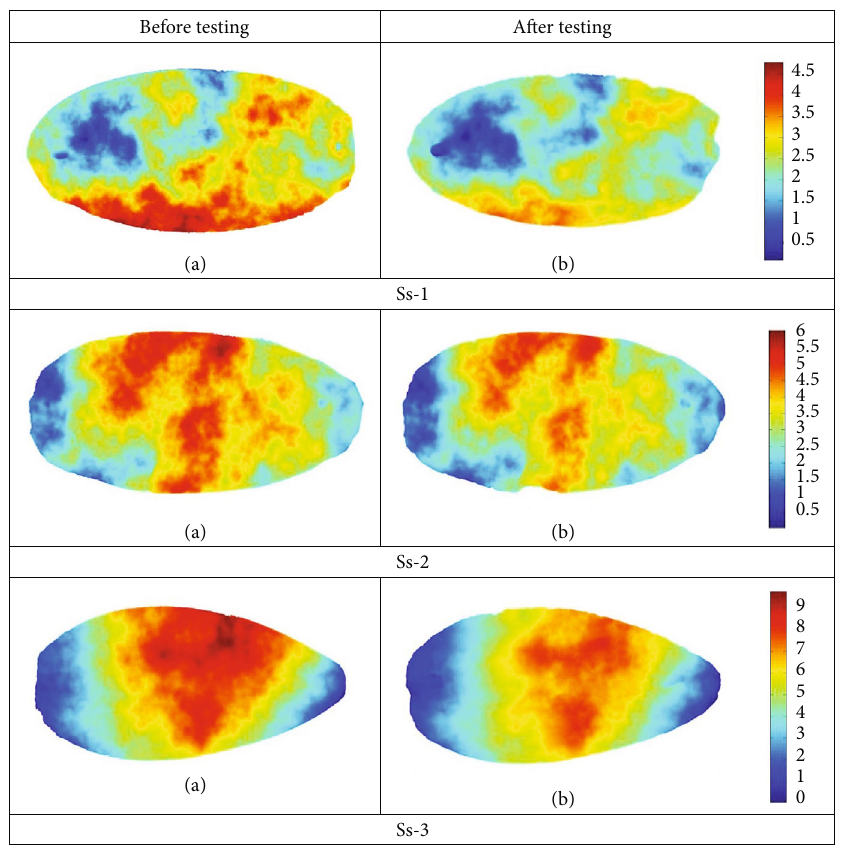
Figure 12: (a, b) Surface scans of samples Ss-1, Ss-2, and Ss-3 before and after testing under static stress.